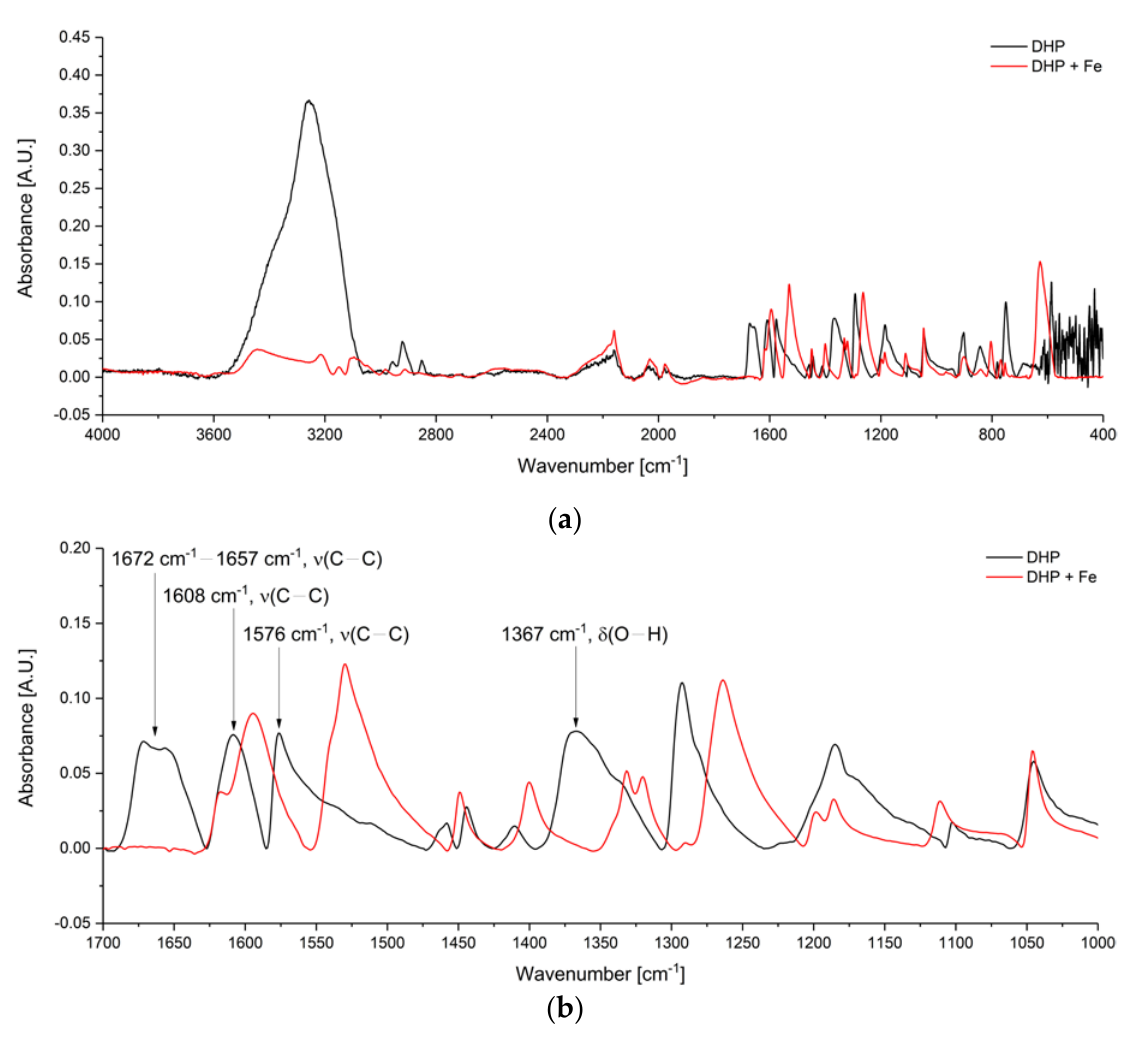
Figure 4. ( a ) MIR spectrum of DHP-coated DLC chip before (black) and after (red) adding 10 µL of mg / mLsolutionFeions. 9.44 mg/mL solution Fe ions. The O–H stretching vibration from the hydroxylic groups and the C-C stretching vibrations disappeared due to coordination to Fe; ( b ) Enlarged region of characteristic absorption features from 1700 cm − 1 to 1000 cm − 1 . The IR peak at 1367 cm − 1 was evaluated for quantification.